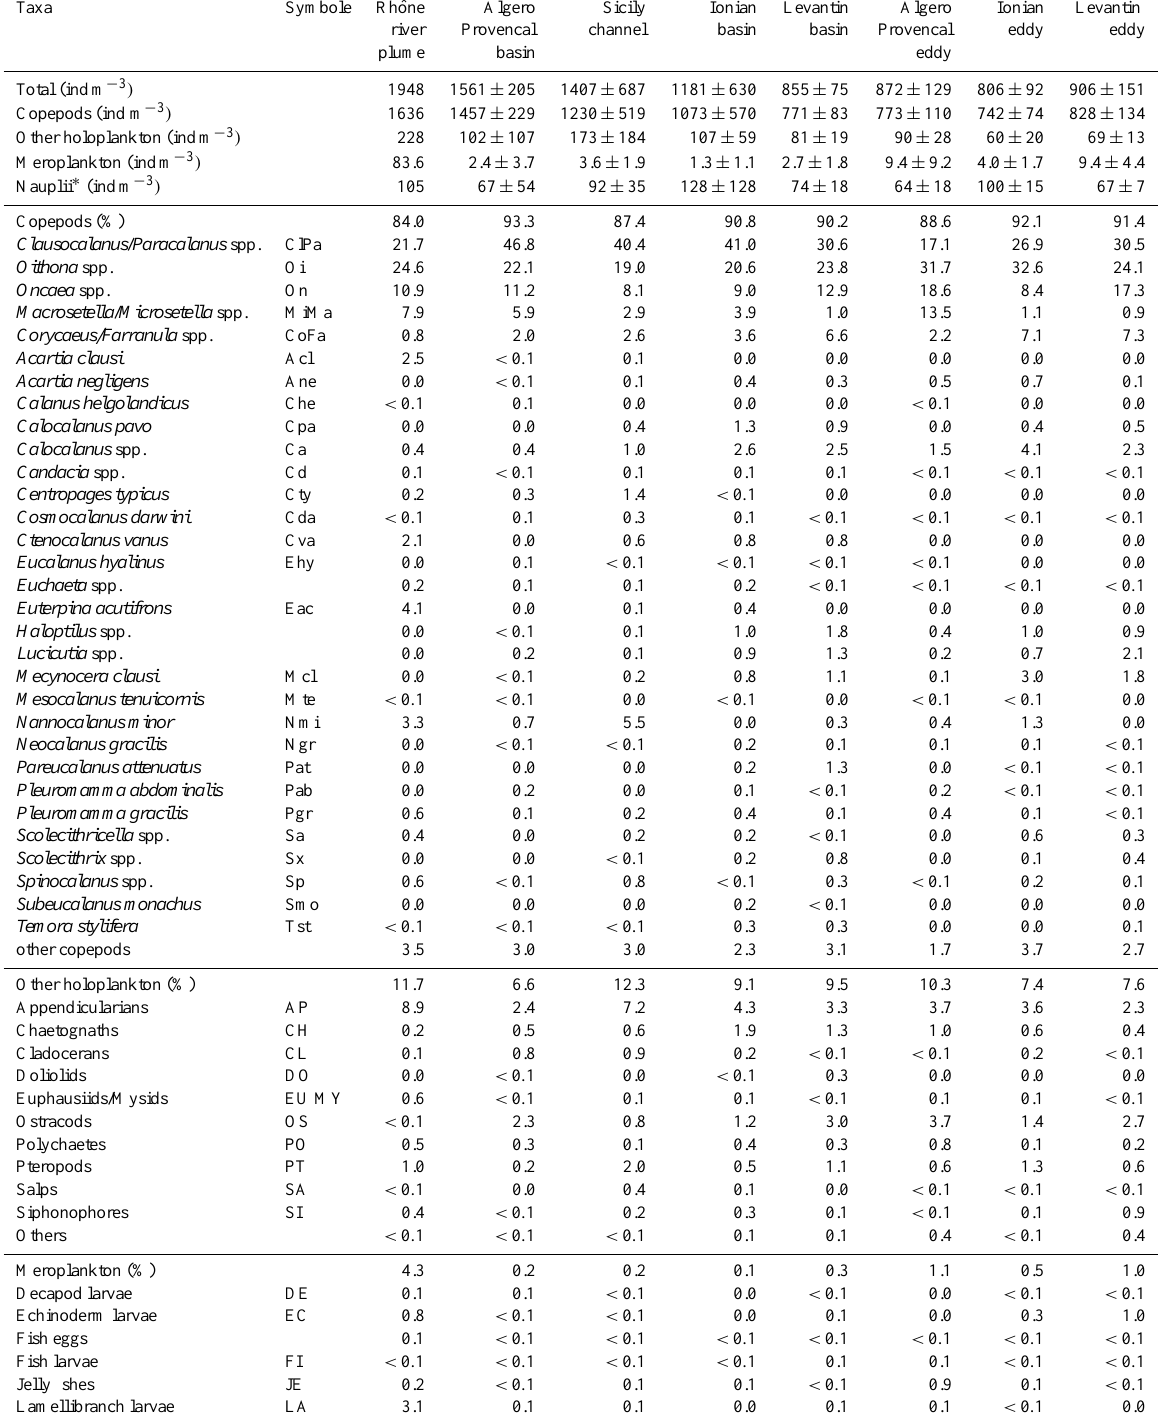
Table 2. Mean integrated abundance ( ± standard deviation) in the upper 200m depth of total zooplankton, copepods, other holoplankton and meroplankton and percentage abundance of the major species and taxa within each category, for the different regions. Unidentified copepods and copepods < 0.1% were grouped as other copepods. Amphipods, isopods and gelatinous larvae were grouped as